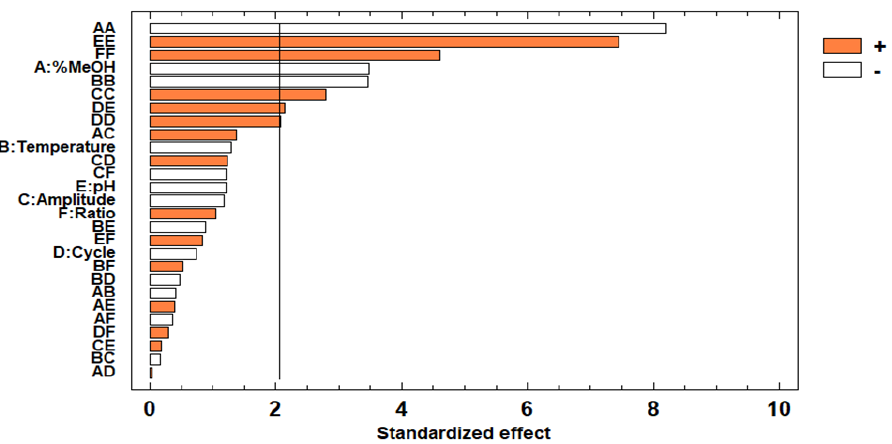
Figure 5. Pareto chart for the total anthocyanins extracted from the sloe samples. Similarly to the phenolic compounds, the above outlined trends can be graphically represented in three-dimensional surface plots obtained from the polynomial equation of the fitted model. The plots illustrate the combined e ff ects of the most significant variables—% methanol in water, pH, and cycle—on the total anthocyanins recoveries (Figure 6).